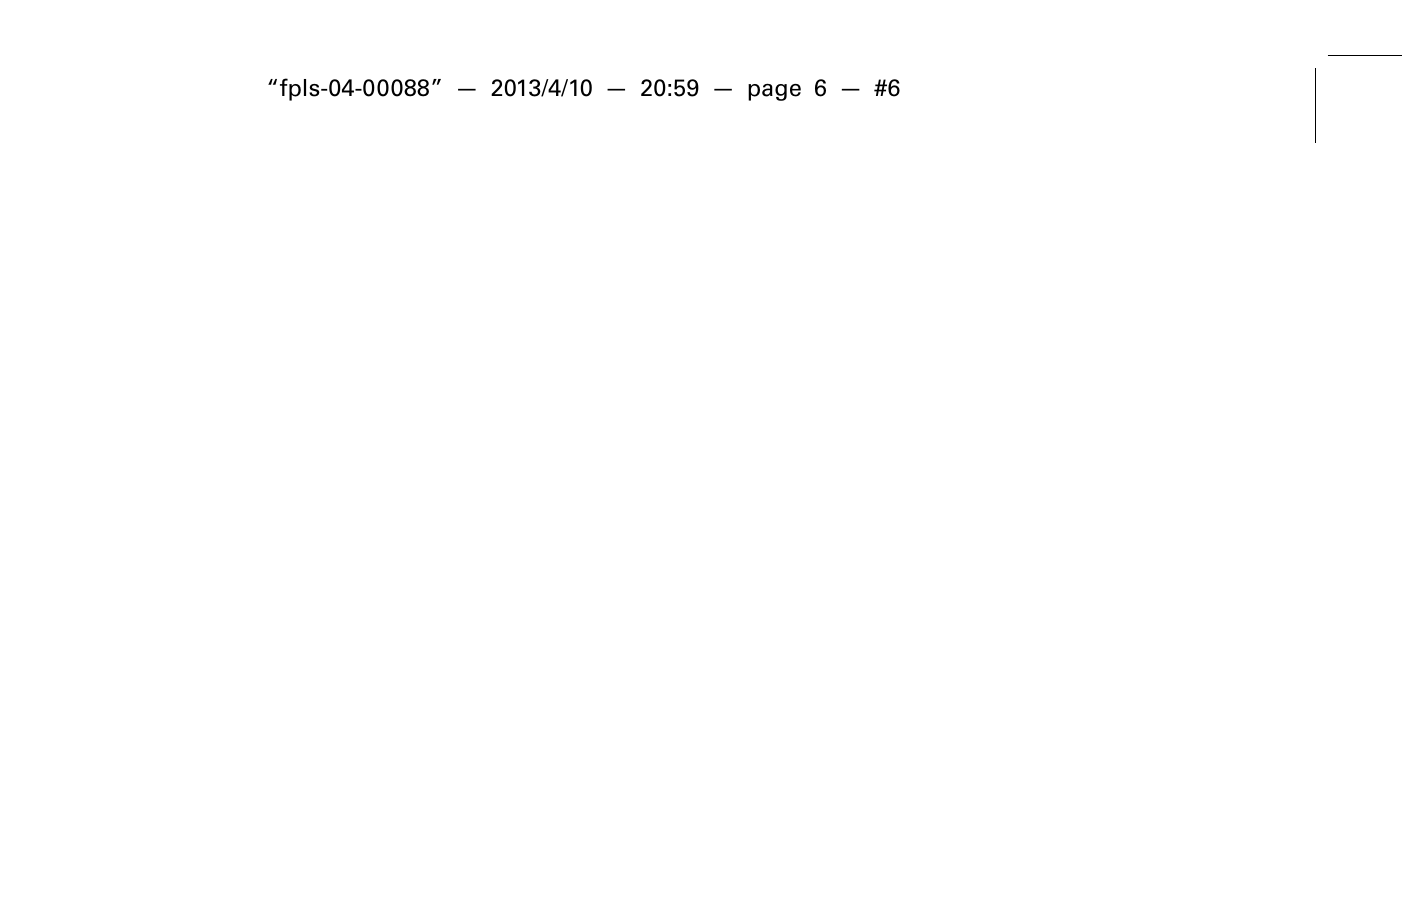
was detected with a specific antiserum in an extract shown in Figure 3A . An unspecific band marked on the X-ray serves as loading control. Exposure of the X-ray film was for 1 min. (C) Immunodetection of NIMIN1 after agroinfiltration. Results from two independent time course experiments are shown. Leaf tissue was extracted after infiltration as indicated. Extracts were analyzed for protein accumulation with a specific antibody. As loading control, the region of the nitrocellulose filters with the small subunit of RuBisCO (SSU) stained with Ponceau S is shown. Exposure of the X-ray films was over extracts from transformed yeast.The NIMIN1 and NIMIN3 fusions were detected with the specific antisera used in Figures 3B,C